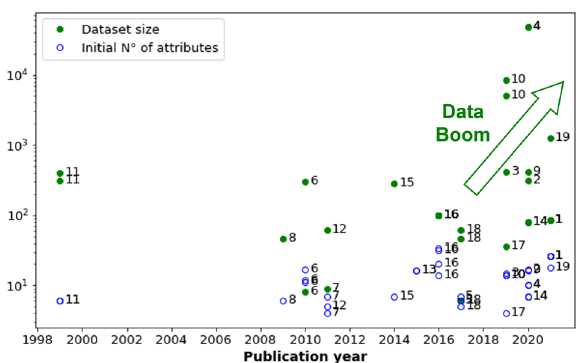
Fig. 2 The “ Data Boom ” effect on the selected ML and corrosion references. The ‘ Dataset size ’ and the ‘ Initial number of attributes ’ (derived from the Machine learning for corrosion database) are presented Vs the publication year.